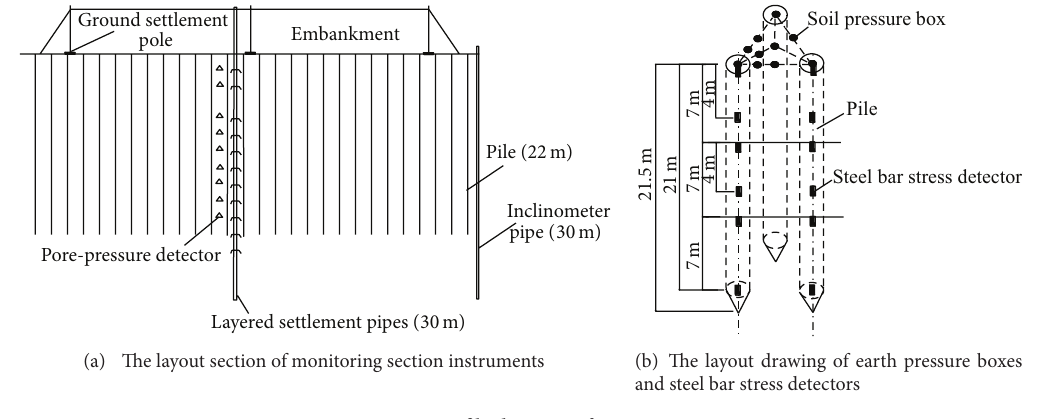
Figure 13: Profile drawing of instruments.